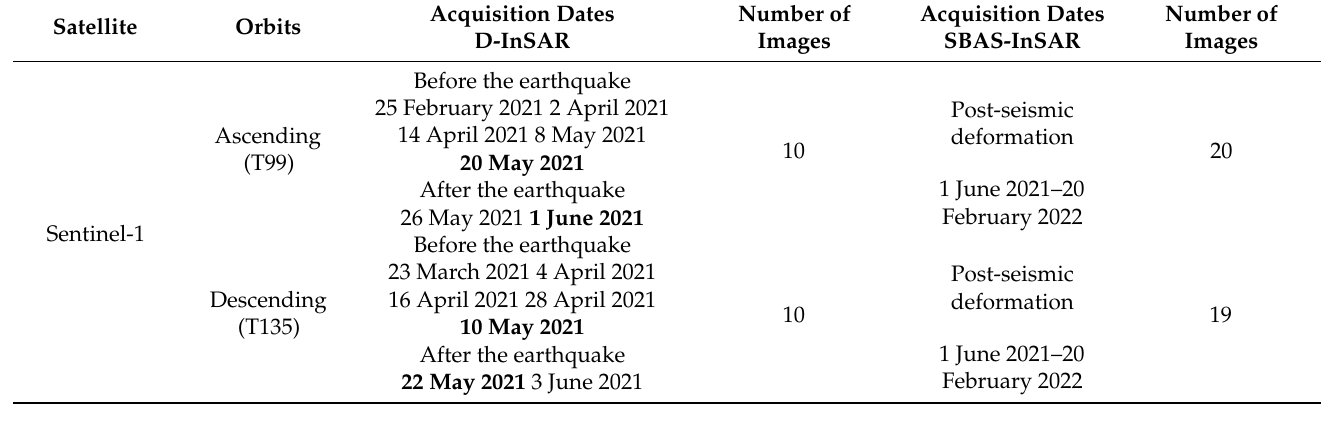
Table 2. Parameters of the SAR images used in this study.